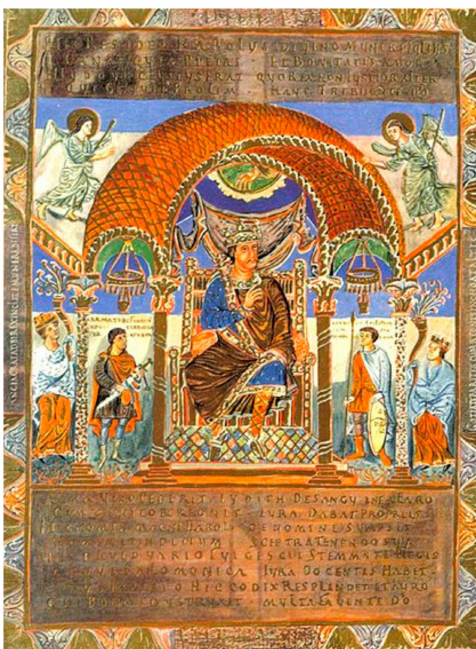
Figure 1. Charles the Bald in Majesty , illumination, 870. Munich, Bayerische Staatsbibliothek, Clm 14,000, Codex Aureus of St. Emmeram , fol. 5v. Public domain image (https: // it.wikipedia.org / wiki / Carlo_il_